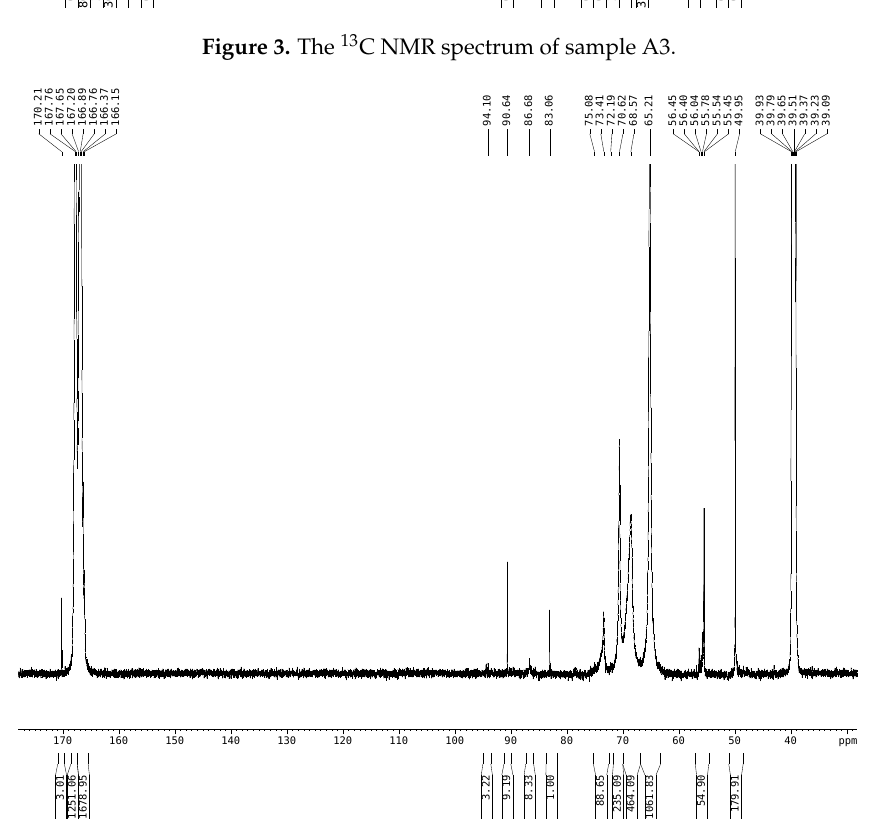
Figure 3. The 13 C NMR spectrum of sample A3.